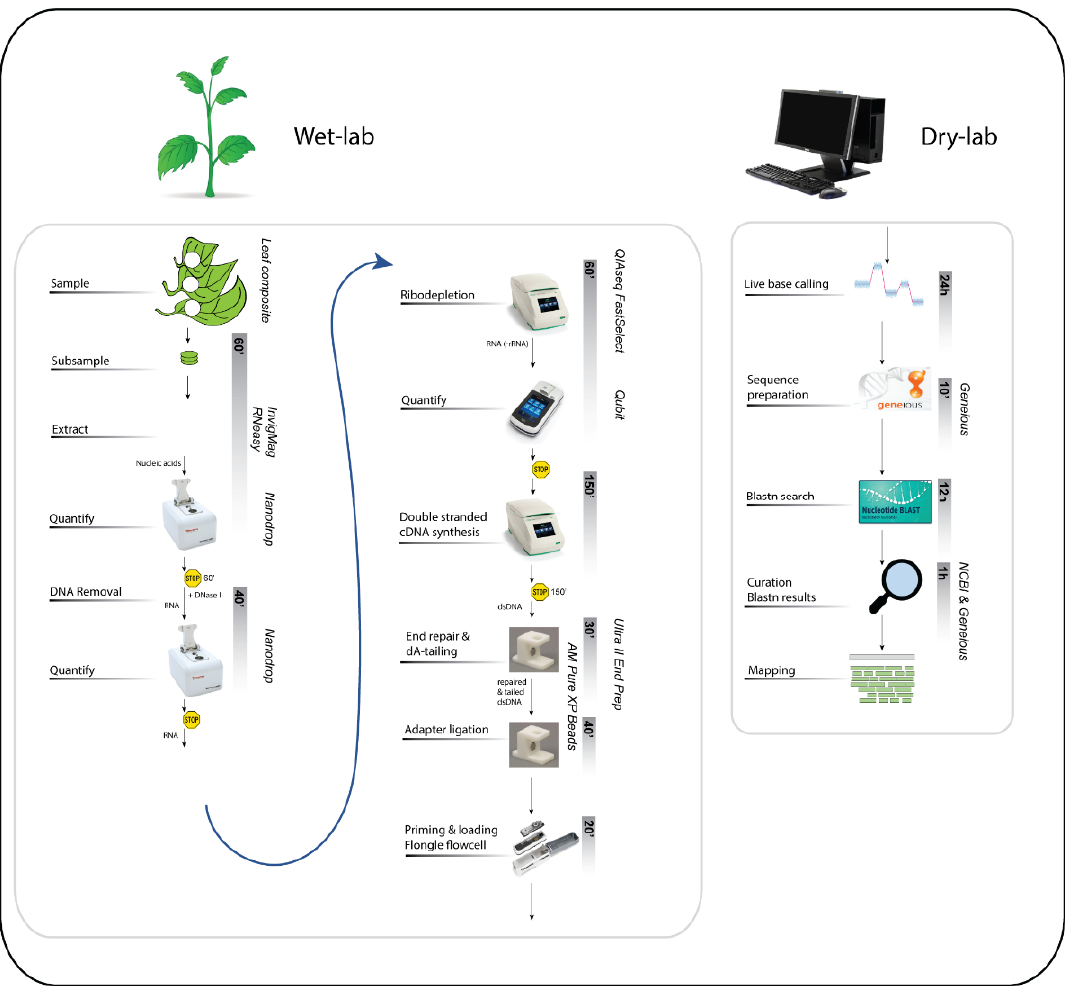
Figure 2. An overview of the main steps of the ONT Flongle plant virus method from wet lab to dry lab. Each activity is listed on the left, with options to pause indicated by the yellow “stop” sign. The estimated duration of each activity is shown within the grey vertical bars. Detailed descriptions of each step are provided below in the Procedure.